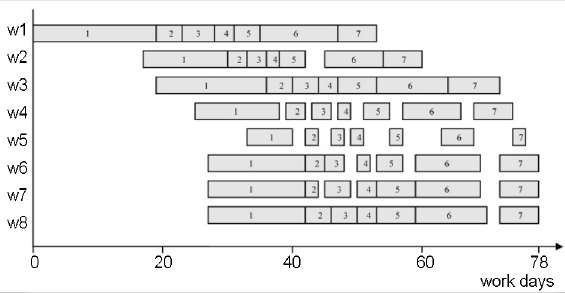
Fig. 7. Building schedule for individual road segments for the permutation accordant to the segments numeration (natural permutation)